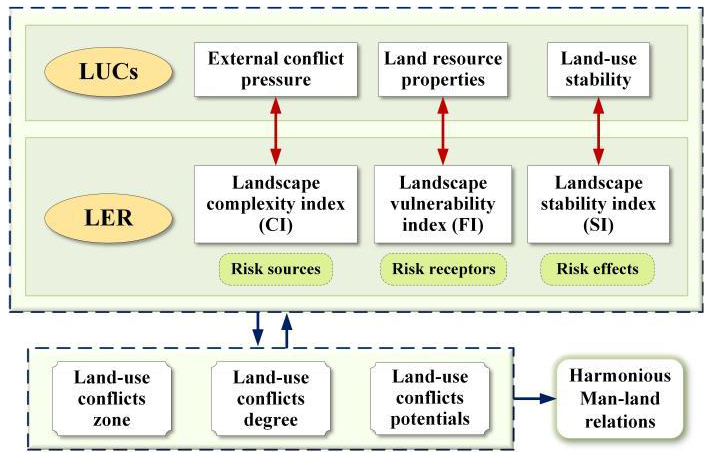
Figure 2. Conceptual framework of coupled LUCs and LER assessment.